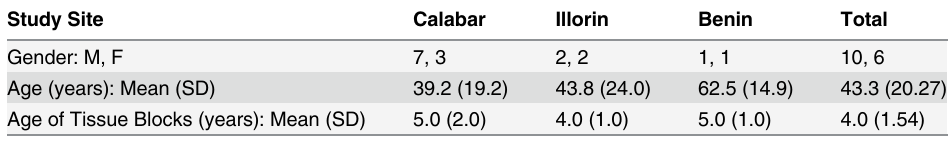
Table 3. General Characteristics of Samples Tested for HBV DNA (n = 17).